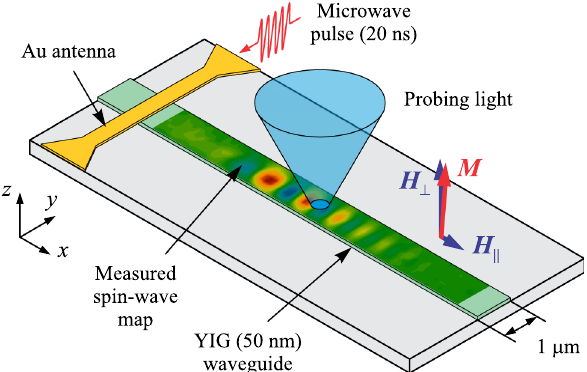
Figure 1. Schematics of the experiment. 20-ns long spin-wave pulses propagate in a 50-nm thick and 1-µm wide YIG waveguide magnetized nearly perpendicularly to its surface. The phase-resolved detection of spin waves is performed by using the micro-focus BLS